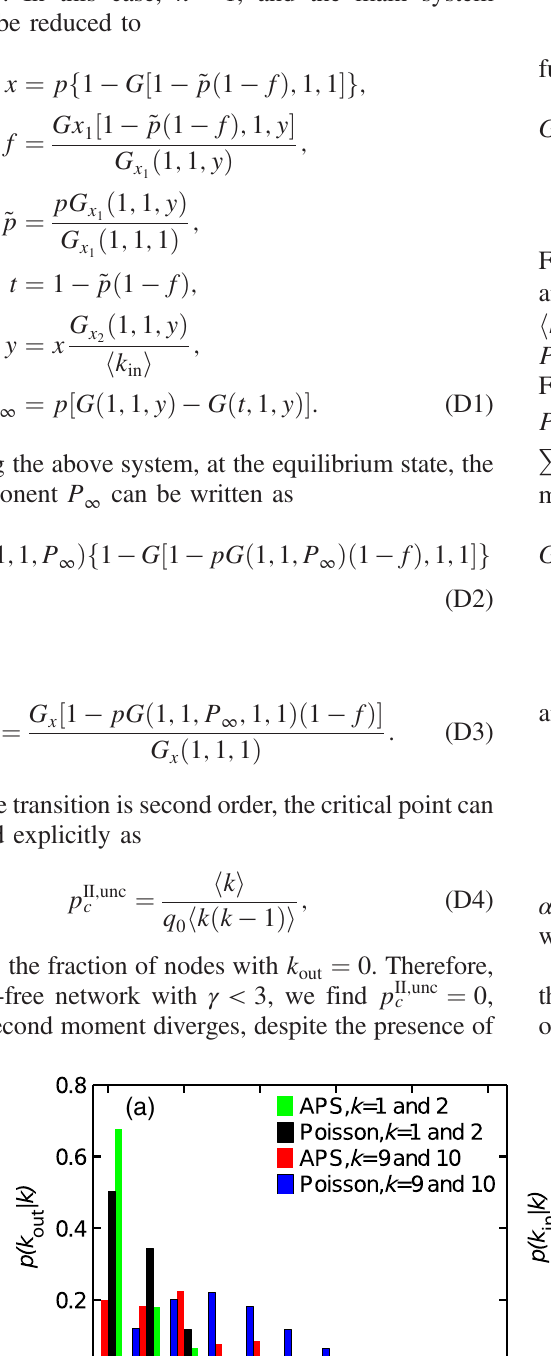
and k for a in out